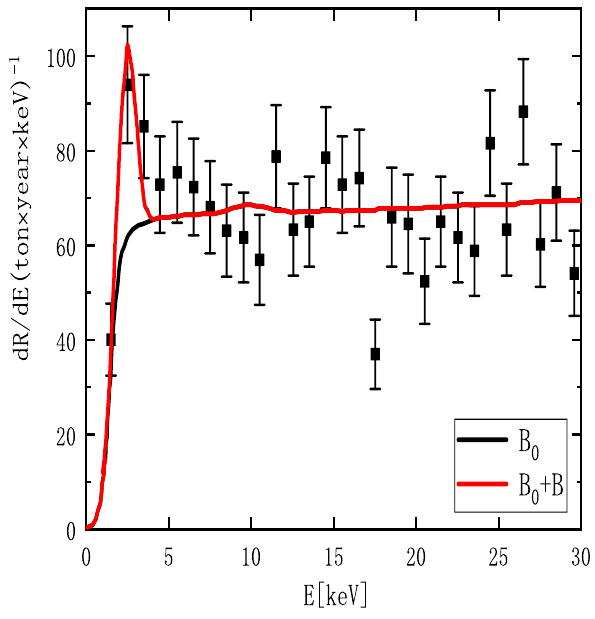
Fig. 1 Fit to the observed data [1] about the number of events dR / dE ( ton year keV ) − 1 asfunctionofthereconstructedelectronrecoilenergy with five different sets of benchmark values C1 to C5 in Table 1, where B 0 and B represents the background and the daughter DM contribution,